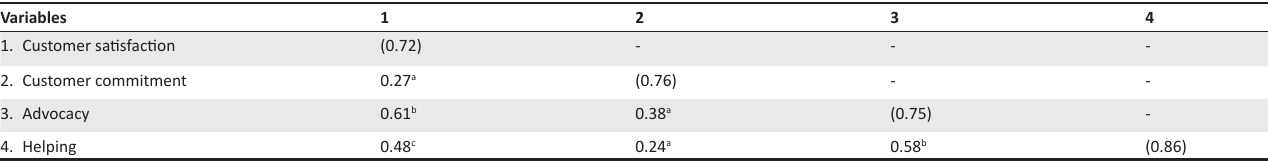
TABLE 1: Correlation matrix for the latent variables with average variance extracted on the diagonal and mean values.